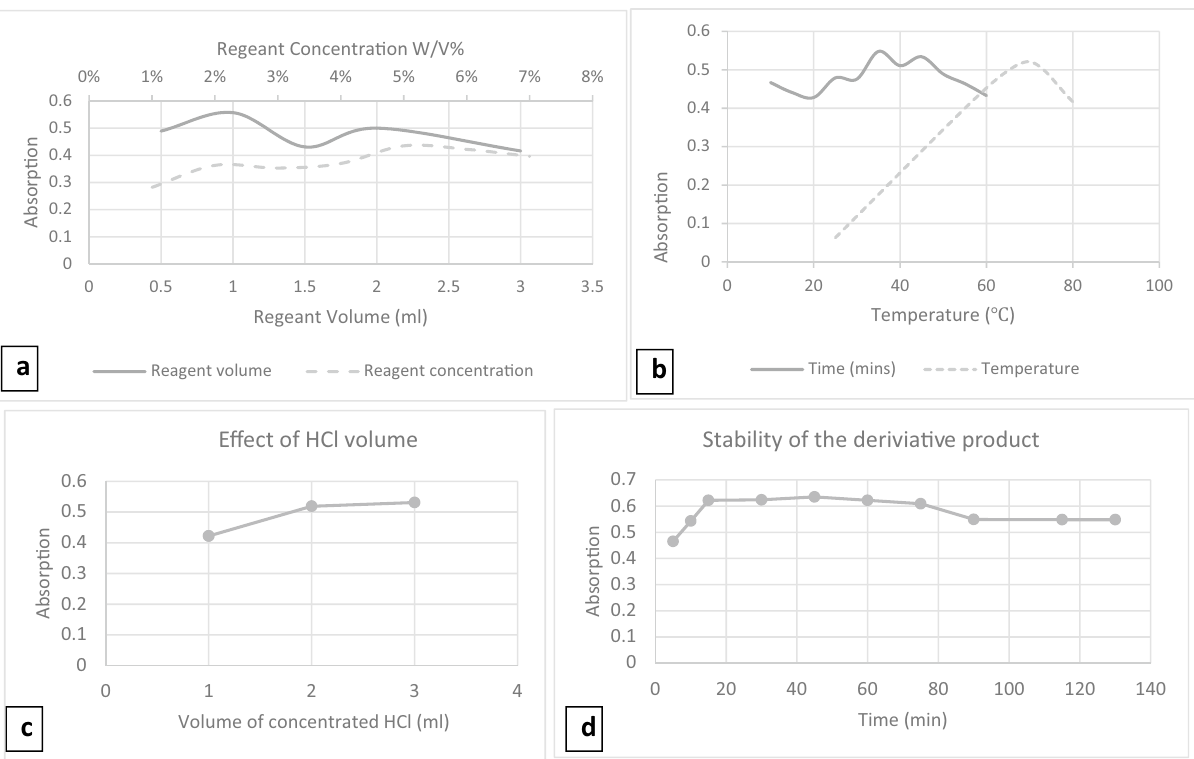
Figure 3. Optimization of Reaction conditions. ( a ) Effect of PDAB concentration (dashed line) and volume (dotted line) on the reaction of LNG with PDAB. ( b ) Effect of temperature (dotted line) and time (dashed line) on the reaction of LNG with PDAB. ( c ) Effect of HCl volume on the reaction between LNG (20 µg/mL) and PDAB 5%. ( d ) Stability of the reaction